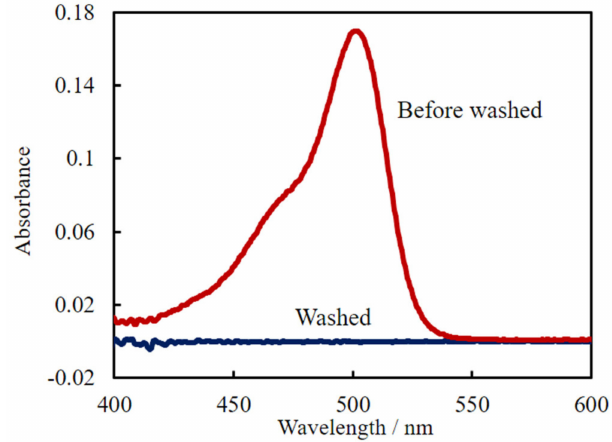
Figure 4. Absorbance spectrum of 1 µ M uranine / 0.25 mM CTAB obtained using the fiber optic probe and that after washing with water.